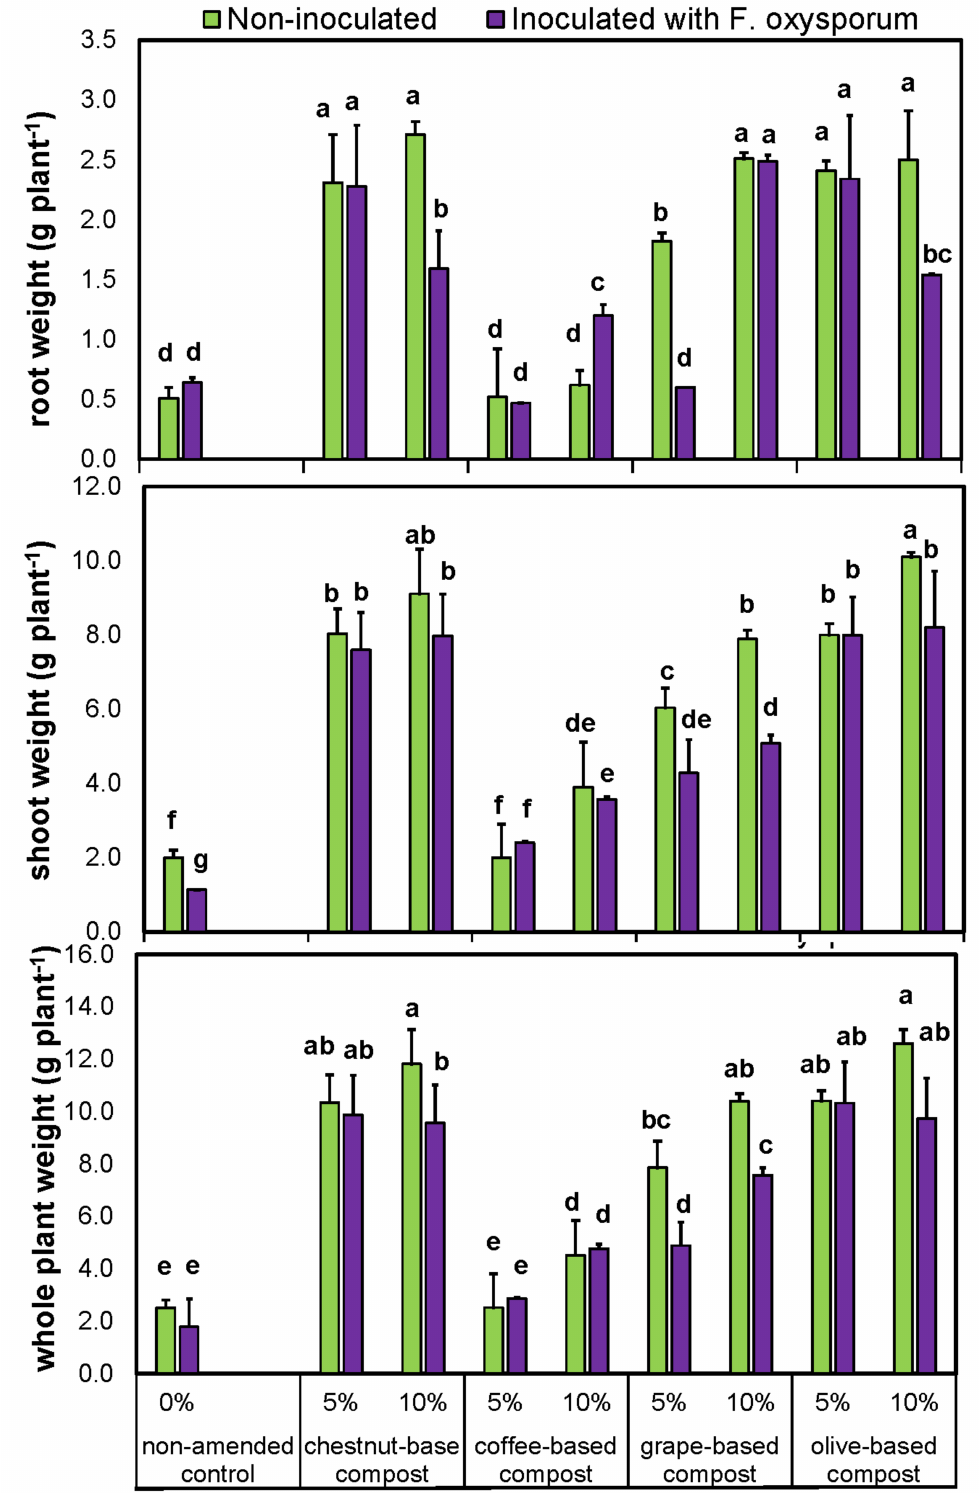
Figure 4. Shoot and root yields (dry weight basis) of lettuce plants grown on soil/compost mixes inoculated with F. oxysporum . The composts were incorporated into soils at proportions of 5% and 10% (weight basis). Control treatments consisted of non-amended soils. Different letters above the bars indicate significant differences among means ( p < 0.05; ANOVA/Tukey’s